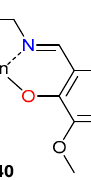
Figure 25. Zn-salen complex 140 active in the ROP of L -LA [82].